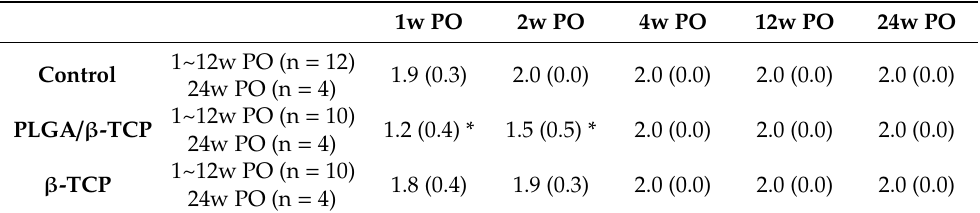
Table 1. Post-operative wound healing score.